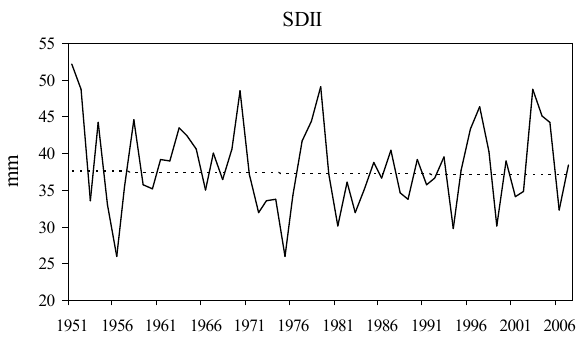
Table 5. Trend analysis of precipitation extremes (with statistical significance values) for the Crkvice and Herceg